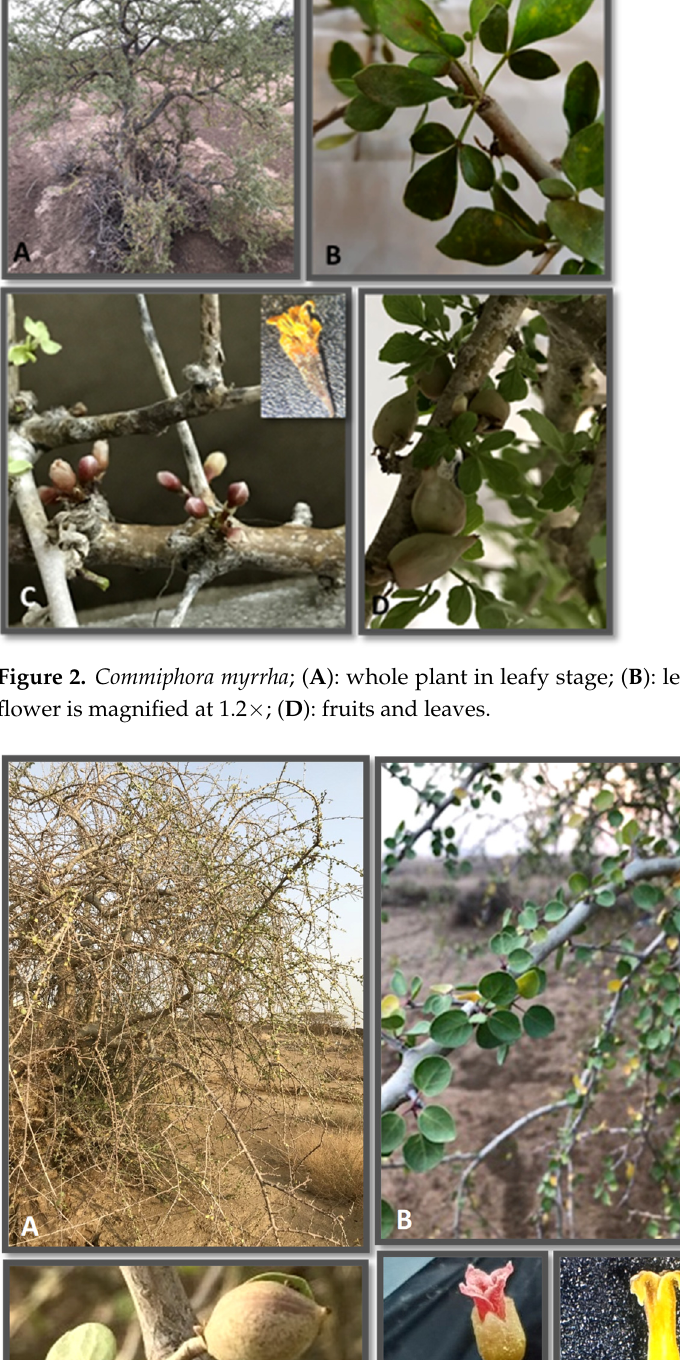
red Leaf texture character was represented by three states: (1) leathery in C. kataf ; (2) pa- pery in C. gileadensis, C. quadricincta, and C. myrrha; and (3) hairy in C. erythraea . Leaf blades were in equal size in only one species, i.e., C. quadricincta , whereas the remaining species were characterized by unequal blades. Red flowers were recorded in C. myrrha